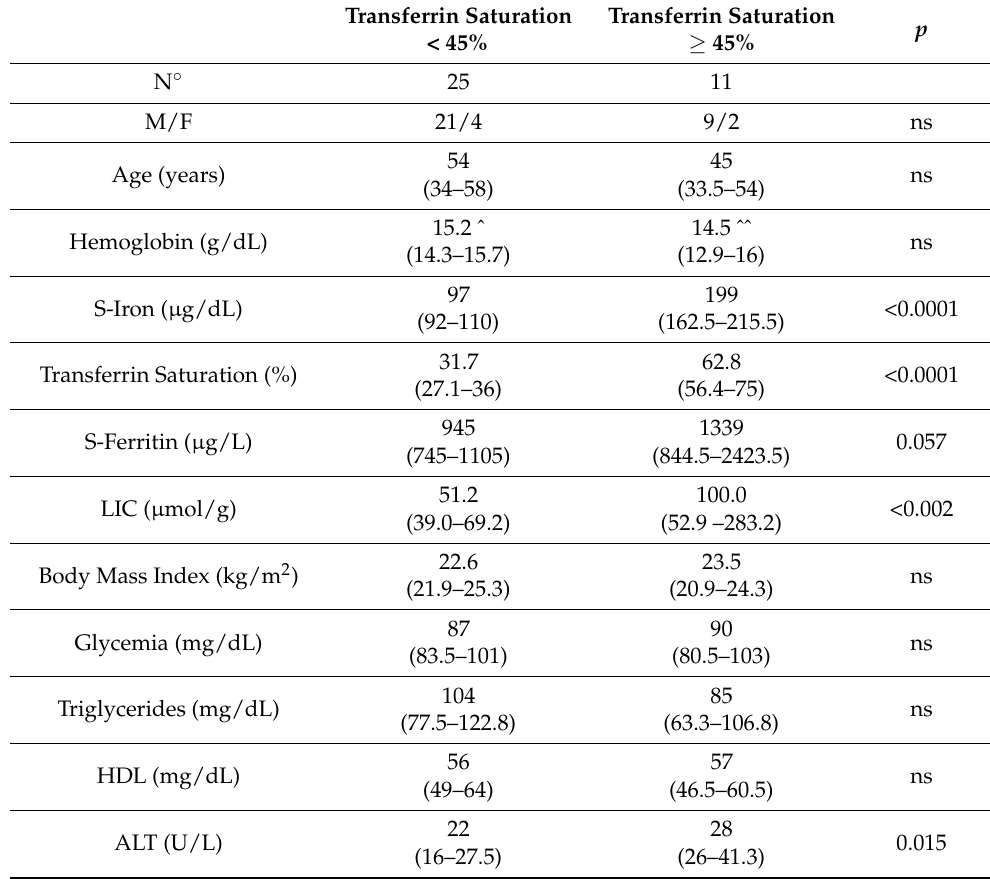
Table 2. Demographic and biochemical data of the 36 patients divided according to transferrin saturation. Data are expressed as median (1st–3rd percentiles), and number (percentage). Transferrin